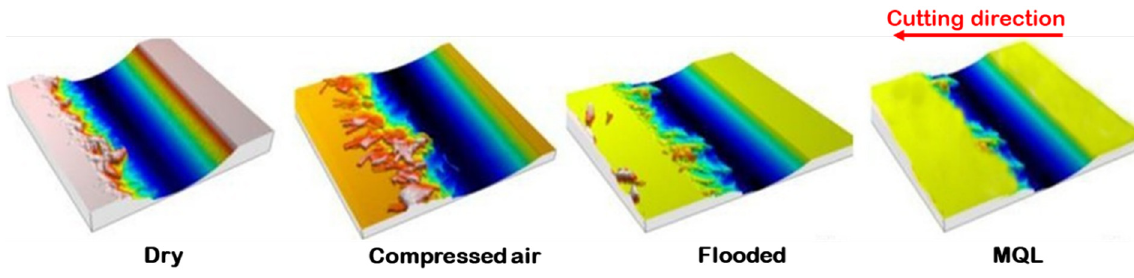
Figure 15. Topography of the machined surfaces due to ploughing effect under different cooling lubrication methods at v = 111 m/min, f = 0.24 mm/rev.